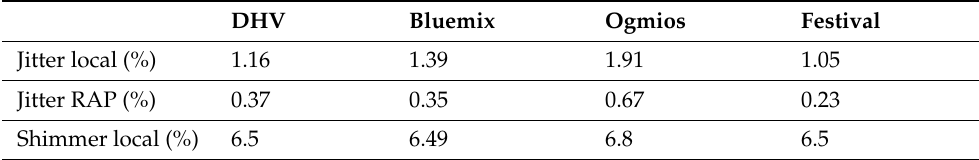
Table 3. Average jitter, jitter RAP, and shimmer (in %) from samples at 25% reduced speed. DHV Bluemix Ogmios Festival Jitter local (%) 1.298 1.612 2.183 1.292 Jitter RAP (%) 0.425 0.416 0.782 0.287 Shimmer local (%) 7.757 7.723 8.115 7.824